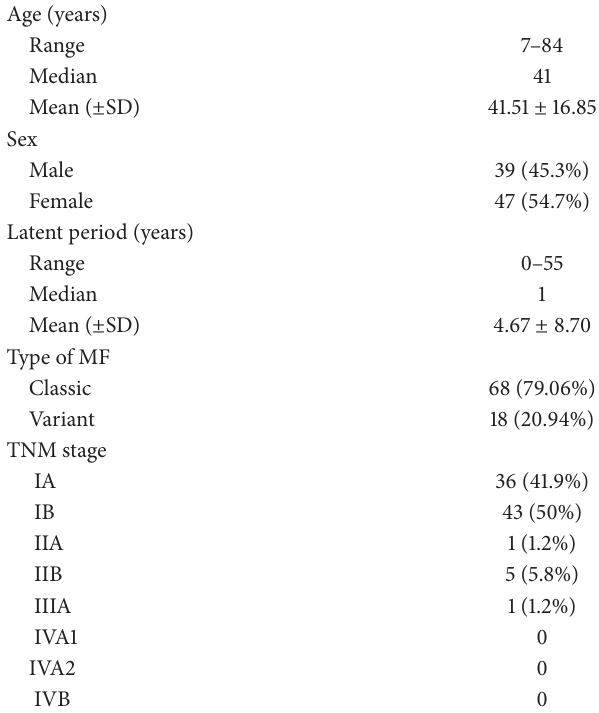
Table 1: Demographic profile and basic data of 86 patients with mycosis